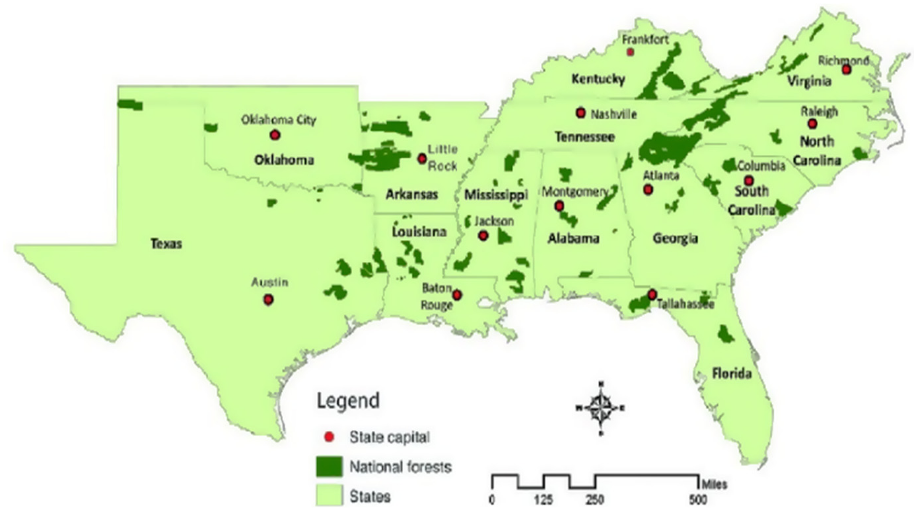
Figure 1. Map reflecting the spatial distribution of the National Forests in the Southeastern region (source: fs.usda.gov/Alabama forest, accessed on 28 March 2017).